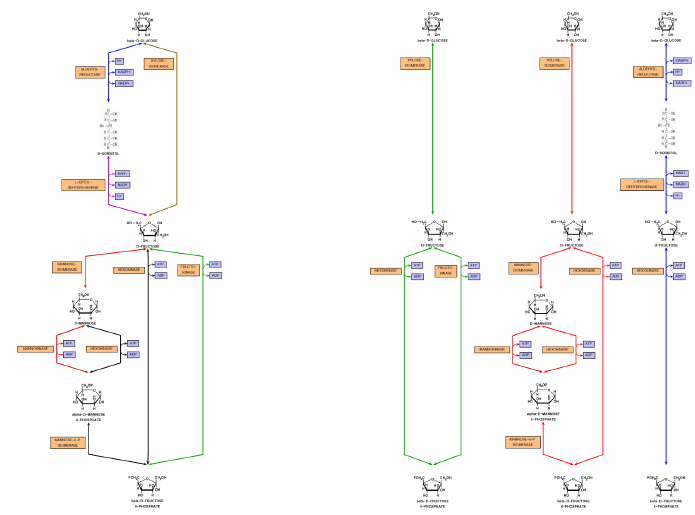
Fig. 3. Visual comparison of metabolic pathways: left - combination of all pathways into one diagram; right - one diagram for each species (pictures from